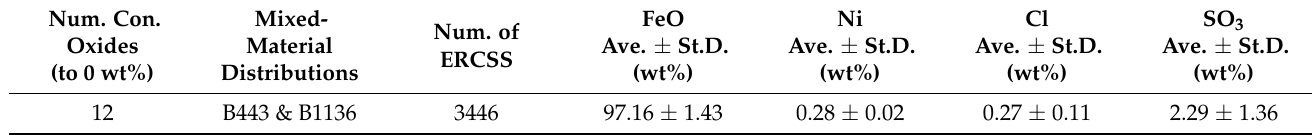
Table 10. Blueberry composition statistics for the third (smallest) group of